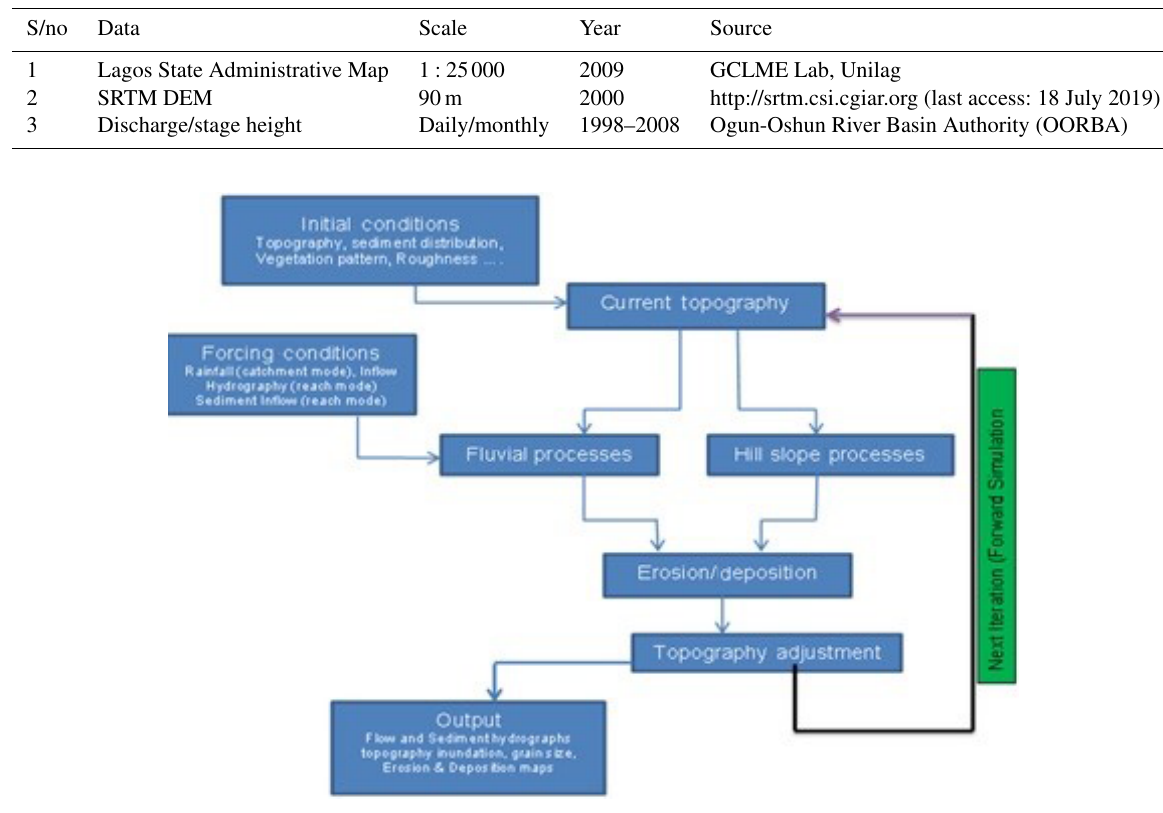
Figure 2. Framework of CEASAR